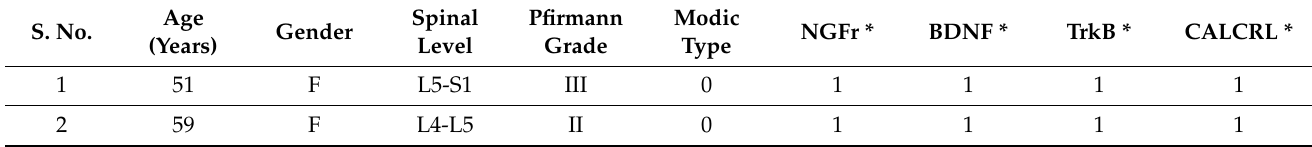
Figure 6. Histograms showing number of quantitative analyses of immunohistochemistry per- formed for ( a ) NGFr/TrkA, ( b ) BDNF, ( c ) TrkB and ( d ) CALCRL in canine IVD-AF tissue sections. * p -values for statistical significance for NTG-101 as compared to PBS-injected canine IVDs.